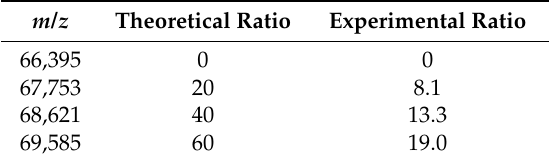
Table 3. Influence of SIA excess on activation level of bovine serum albumin BSA at pH 7.4.